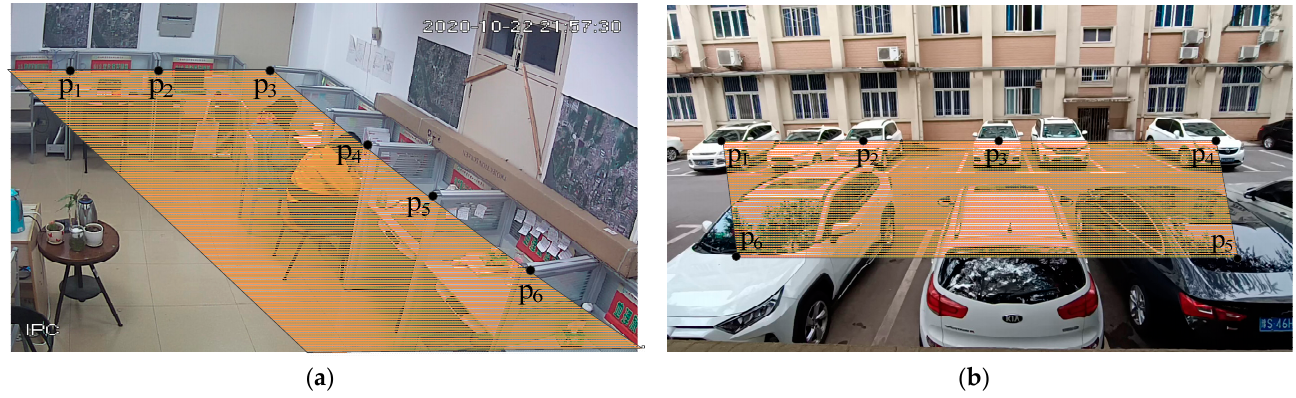
Figure 2. The virtual plane. The left image ( a ) is an indoor scene and the right image ( b ) is an outdoor scene.